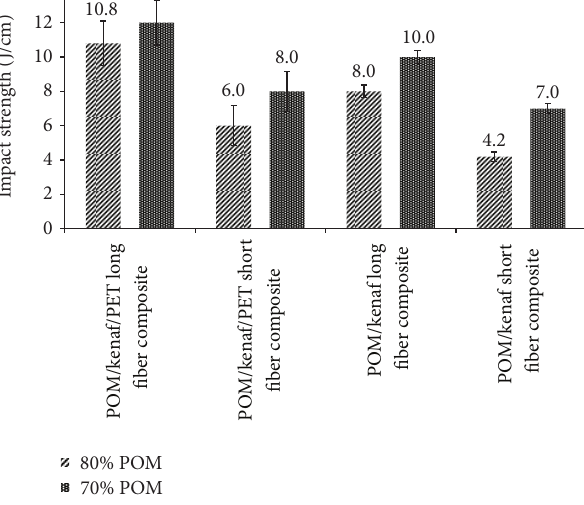
Figure 11: Impact strength of the controlled samples.